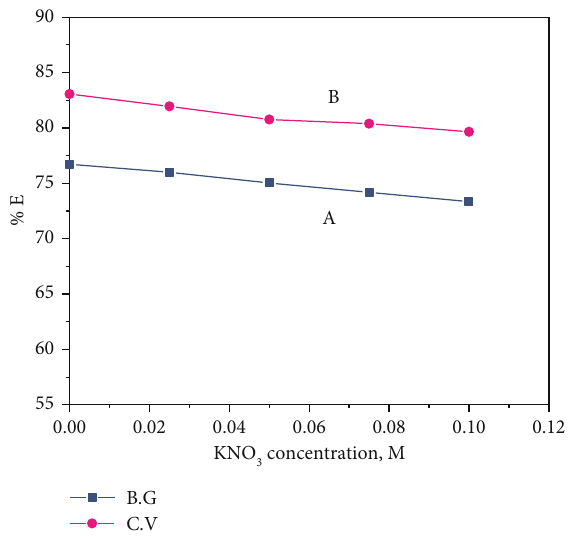
on the adsorption Figure 12: Weber – Morris scheme of the sorbed B.G. and C.V. dyes 3 from aqueous solutions to the binary P3NT/30%AgTiO NCs at 22 ° C temperature. versus the square root of time. Experimental conditions are 2 expressed in the batch extraction step.